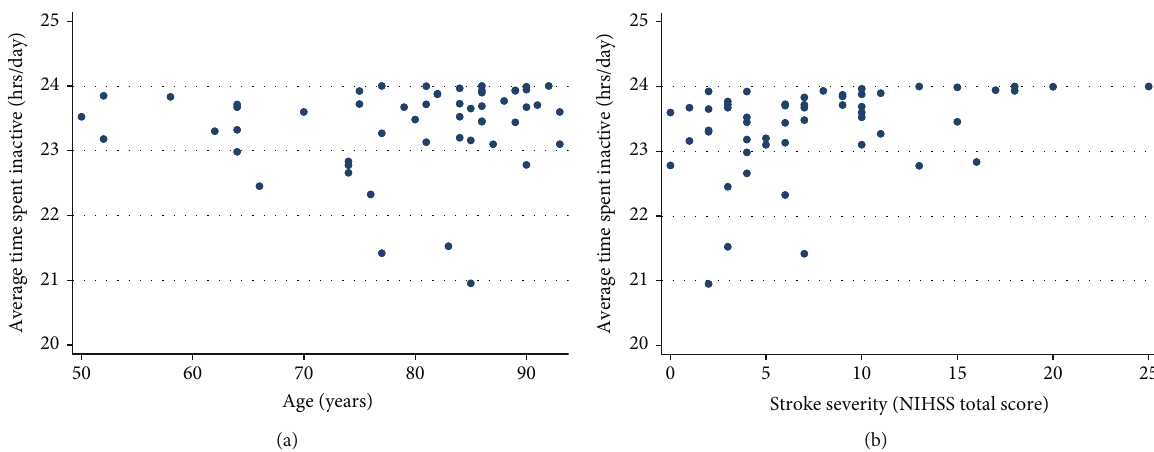
Figure 2: (a) Scatterplot: weak nonsigni fi cant correlation between of time spent inactive (hrs/day) and age (years). (b) Scatterplot: moderate, positive, and signi fi cant correlation between of time spent inactive (hrs/day) and stroke severity (NIHSS total score). NIHSS =National Institutes of Health Stroke Scale: a higher score indicates more severe stroke